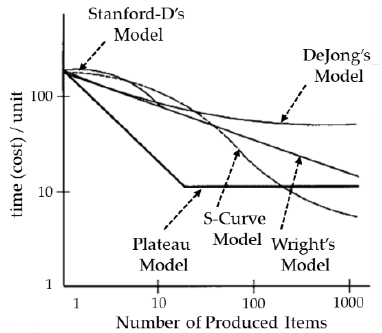
Figure 3. Adapted log-linear learning curve models graphics [10,13 – 17].